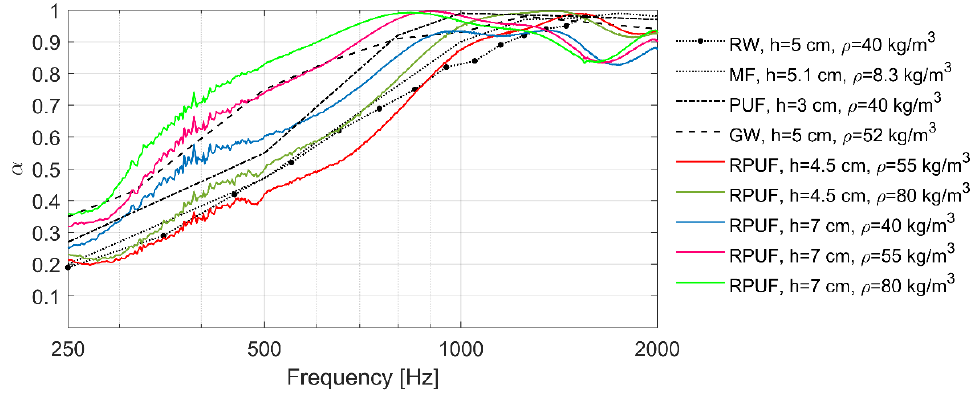
Figure 15. Comparison of the considered rebonded polyurethane foams with traditional vibro- acoustic materials.